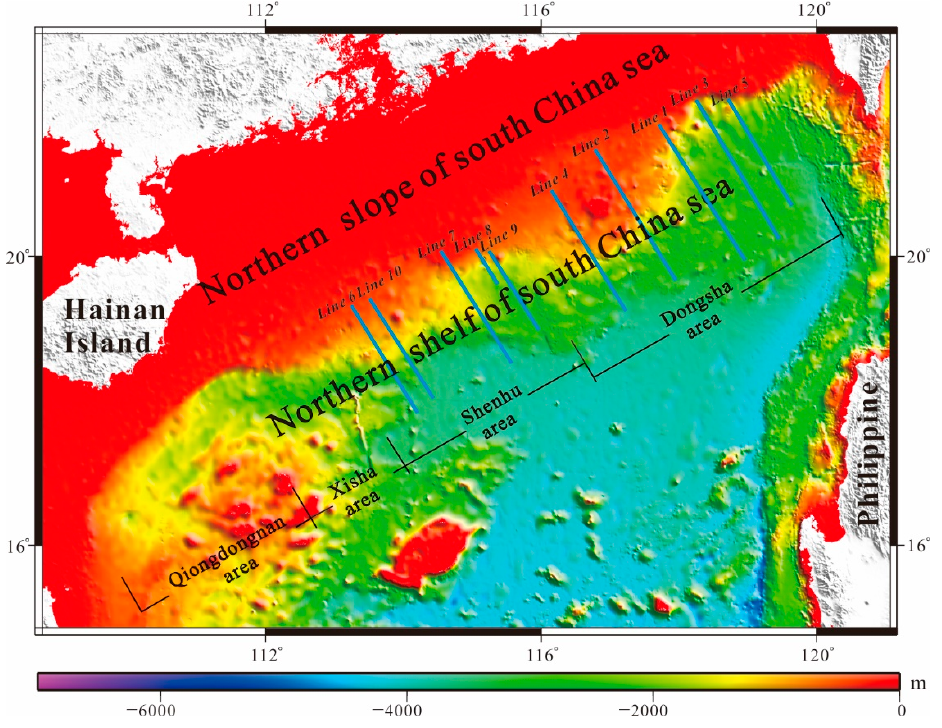
Figure 1. Location of study area-the northern slope of South China Sea [48].